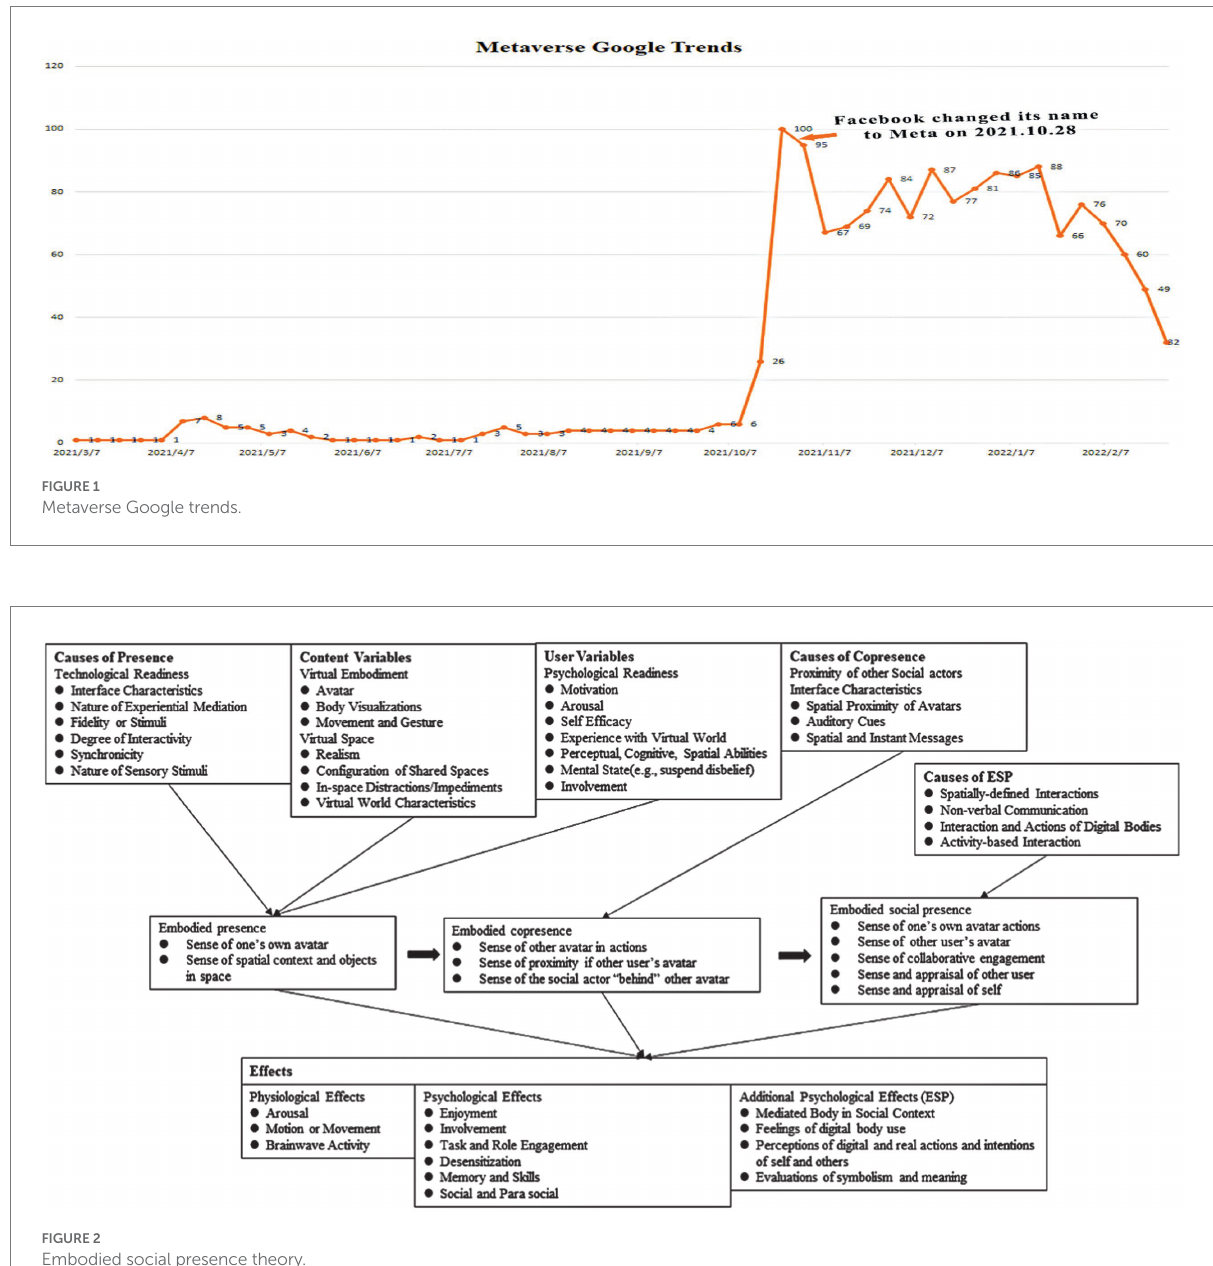
FIGURE 2 Embodied social presence